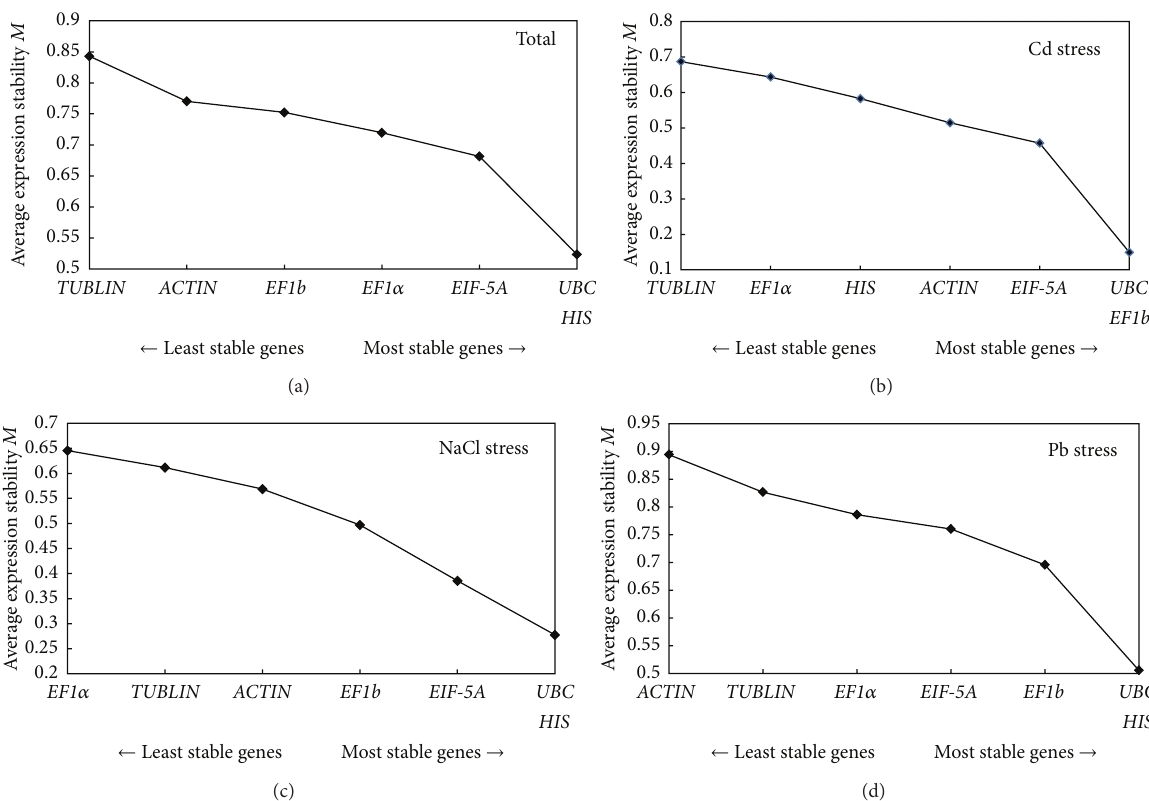
Figure 2: Average expression stability values of control genes by GeNorm analysis: (a) all stresses combined; (b) Cd stress exposure; (c) NaCl stress exposure; (d) Pb sress exposure. The least stable genes are on the left, and the most stable on the right.